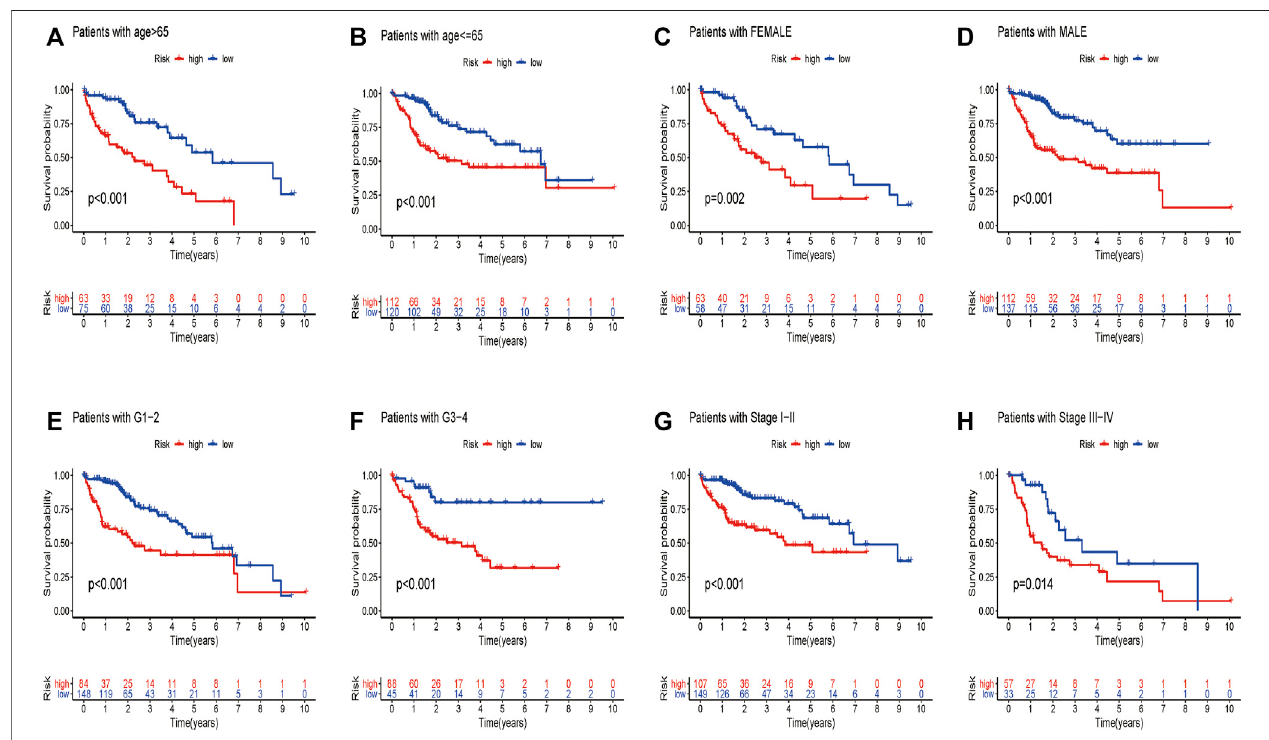
FIGURE 8 | Different overall survival of HCC patients between two groups are shown by classifying patients with age (A,B) , gender (C,D) , grade (E,F) , and stage (G,H) .